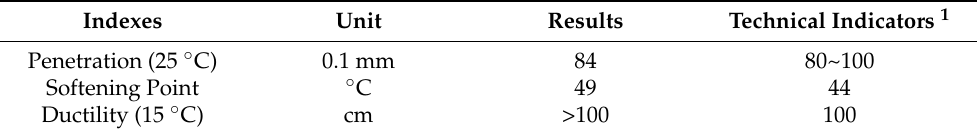
Table 1. Main technical indexes of 90# base asphalt binder.